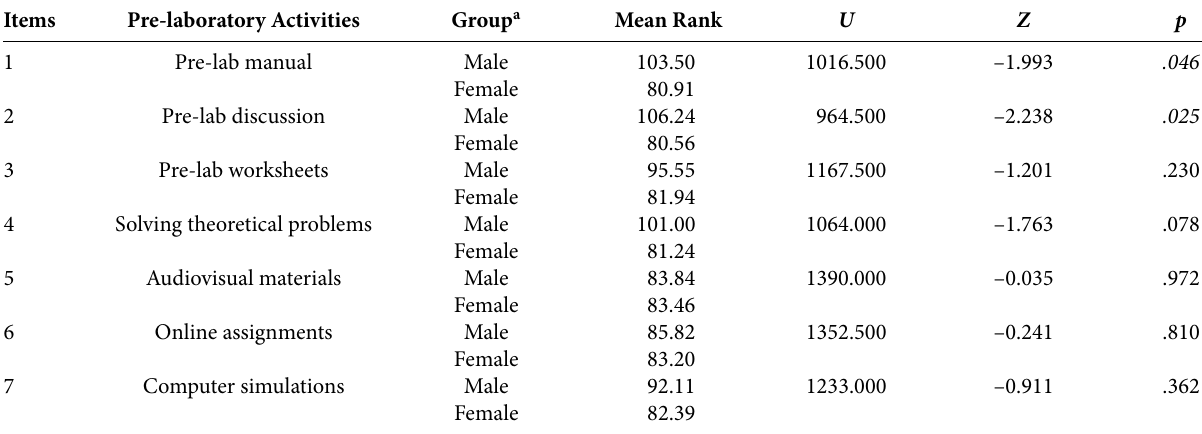
Table 2. The results of the Mann–Whitney U test (two-tailed) of statistically significant gender differences in the chemistry teachers’ use of pre-lab- oratory activities ( N (male) = 19; N (female) = 147)